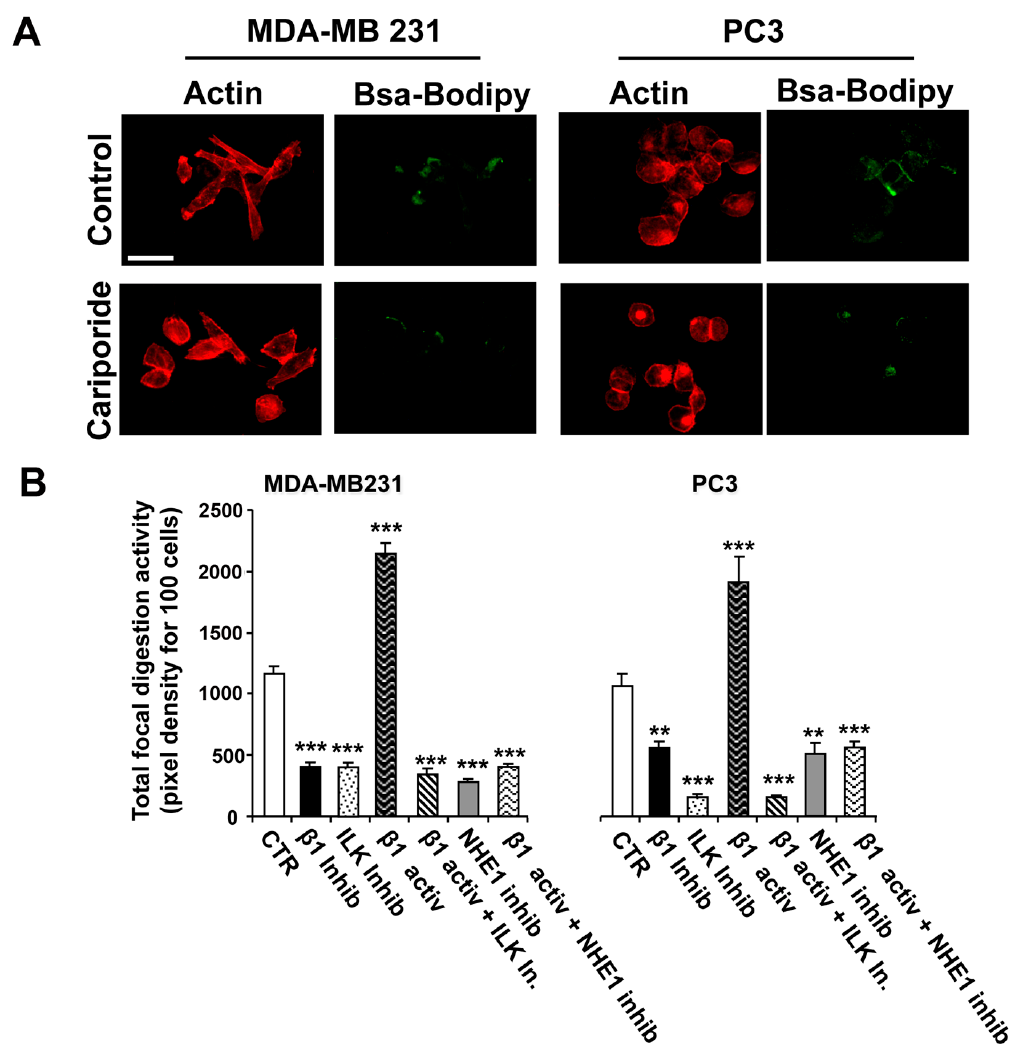
Figure 3. ILK and NHE1 activity are necessary for β 1-integrin-driven invadopodia proteolytic activity. To examine the role of NHE1 and ILK in invadopodial-dependent focal digestion of the ECM, MDA-MB-231 and PC3 cells were plated on Matrigel with DQ-Green BSA and, 1 h later, were treated with either the NHE1 inhibitor, ILK inhibitor, β 1-integrin inhibiting antibody or β 1-integrin activating antibody, with the β 1-integrin activating antibody added in either the presence or the absence of the specific NHE1 or ILK inhibitor. After 24 h, ECM digestion was analyzed using fluorescence microscopy for a series of individual cells as described in the Materials and Methods. ( A ) Typical experiment showing control and cariporide-treated cell. ( B ) Histograms showing Mean ± S.E.M., n = 4, ** p < 0.05, *** p < 0.001 for focal proteolysis compared to the control